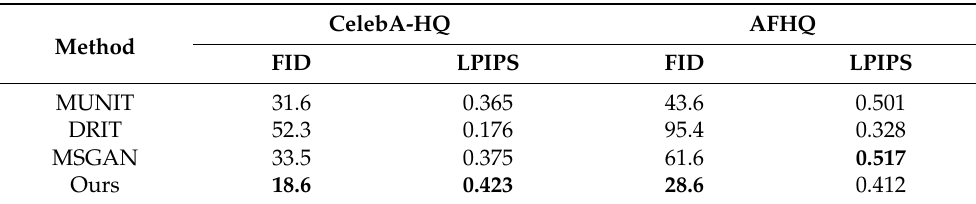
Table 1. Quantitative comparison of latent-guided synthesis. (The bold number indicates the best result.)